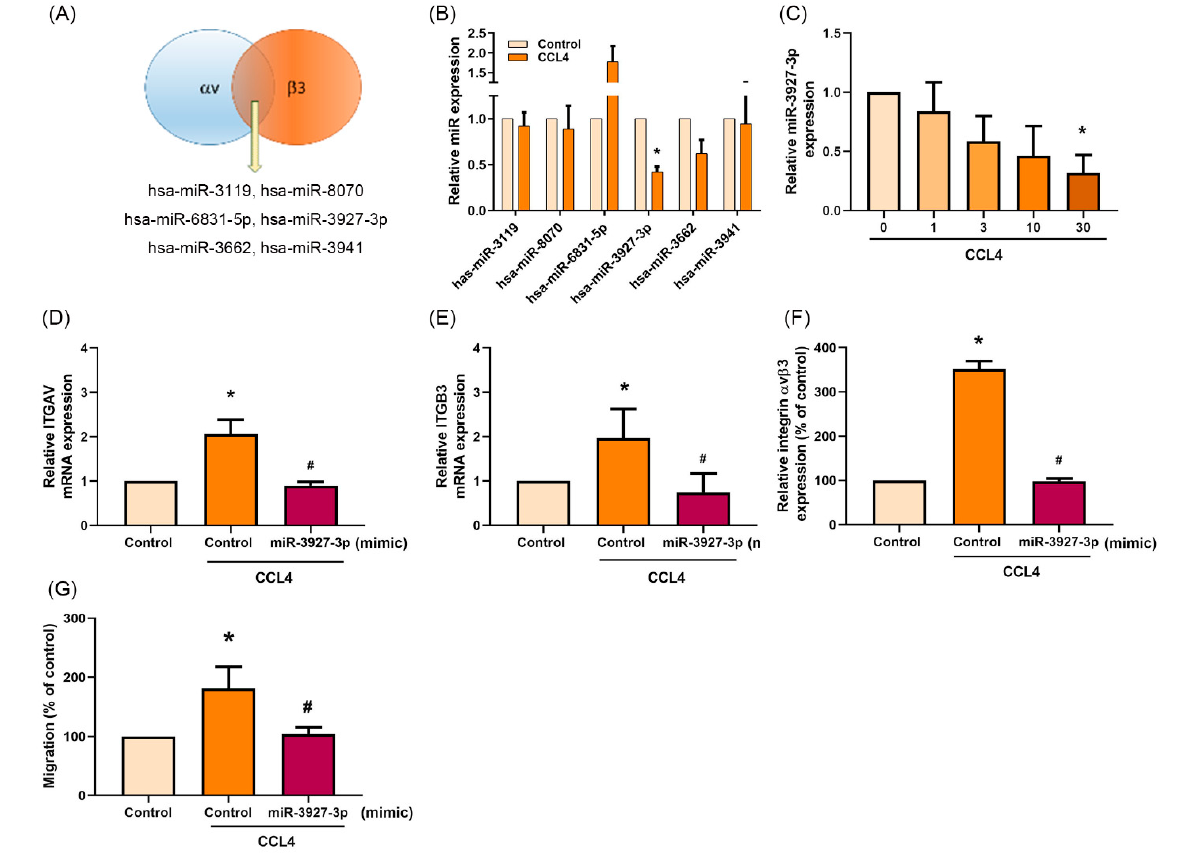
Figure 6. Downregulation of miR-3927-3p increases levels of integrin α v β 3 expression and osteosarcoma cell migration. ( A ) The miRDB database (http://mirdb.org/miRDB, accessed on 19 June 2019) was used to predict miRNAs that potentially bind to the integrin α v- and β 3-3 ′ UTRs. ( B ) 143B cells were incubated with CCL4 (30 ng/mL) for 24 h and the qPCR assay determined levels of expression for all indicated miRNAs. ( C ) 143B cells were incubated with CCL4 (0–30 ng/mL) for 24 h and miR-3927-3p expression was determined by qPCR. ( D – G ) 143B cells were transfected with miR-3927-3p mimic then stimulated with CCL4 for 24 h. Levels of ITGAV mRNA ( D ), ITGB3 mRNA ( E ), cell surface integrin α v β 3 protein expression ( F ), and cell migratory abilities ( G ) were examined by qPCR, flow cytometry, and the Transwell assay, respectively. The results were obtained from three independent experiments and are expressed as the means ± SD. * p < 0.05 compared with controls; # p < 0.05 compared with CCL4-treated controls.